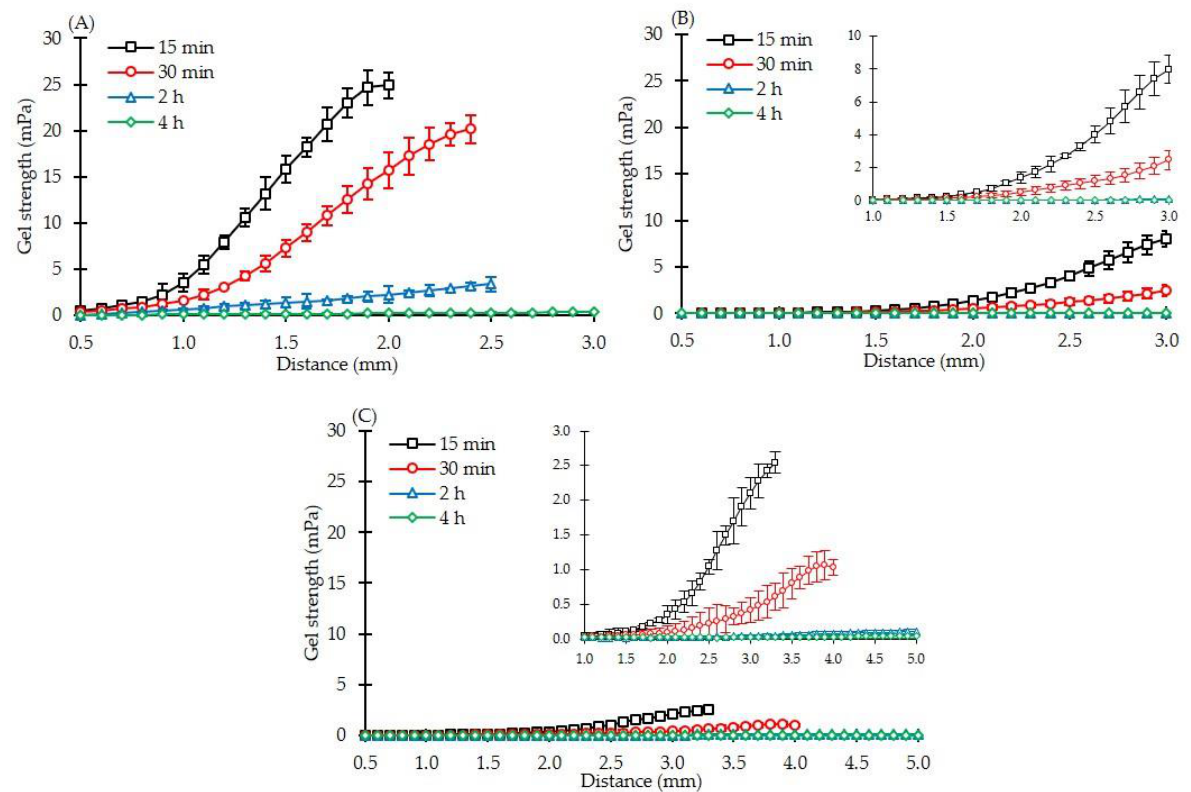
Figure 3. Gel strength profiles of IBU-P407 effervescent matrix tablets ( n = 5); ( A ) IPM, ( B ) 5E and ( C ) 10E. Table 2. Estimated gel layer height and strength at the gel–solution interface tested in pH-changed media ( n =